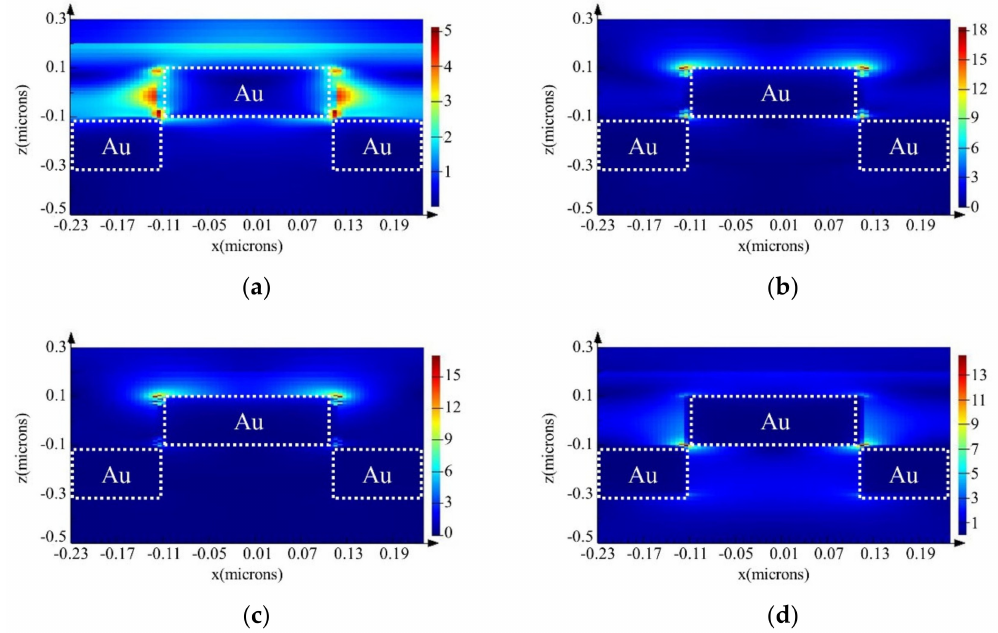
Figure 6. Electric field intensity distribution by LSPR on the gold nanostructures. ( a ) 532 nm, ( b ) 635 nm, ( c ) 650 nm, and ( d ) 785